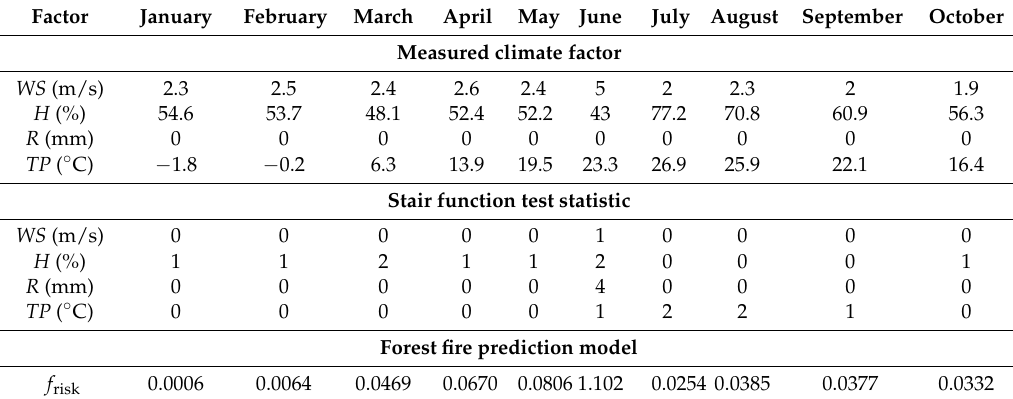
Table 4. Risk Analysis of Forest Fire in Mt. Surak,